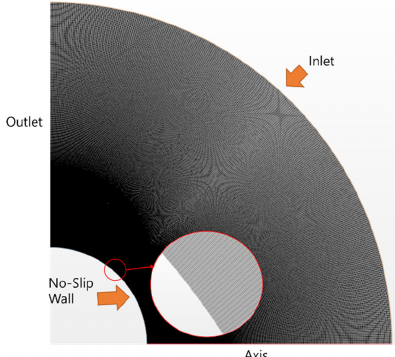
Figure 1. Computational grid and boundary conditions.